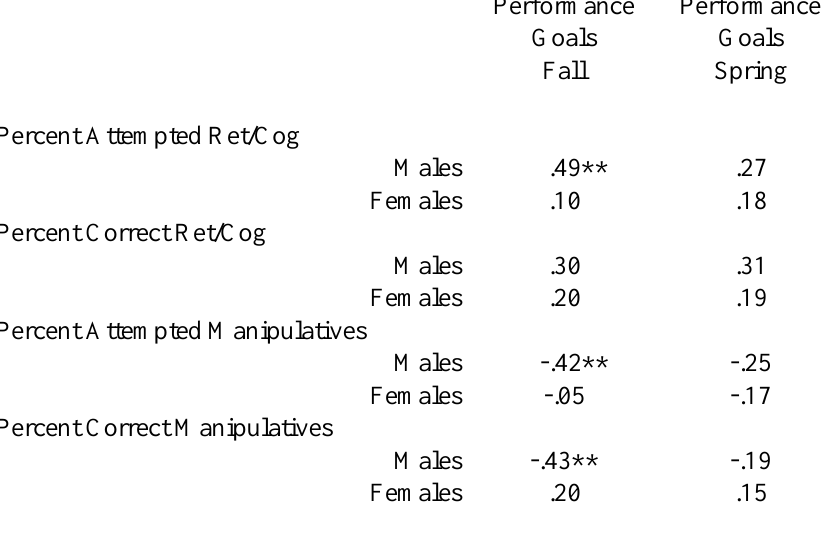
Performance Performance Goals Goals Fall